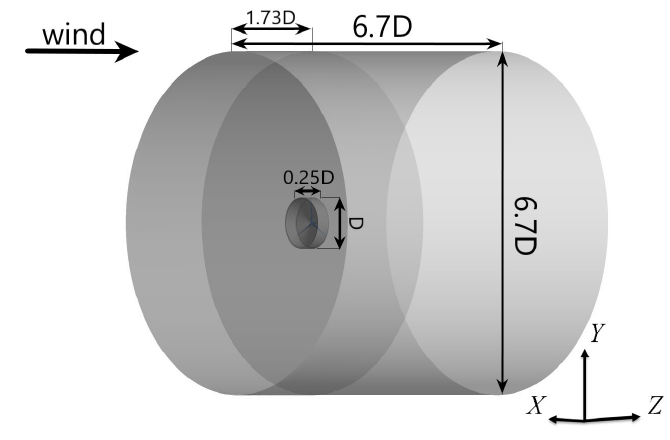
Figure 2. Computational mesh of wind turbine.